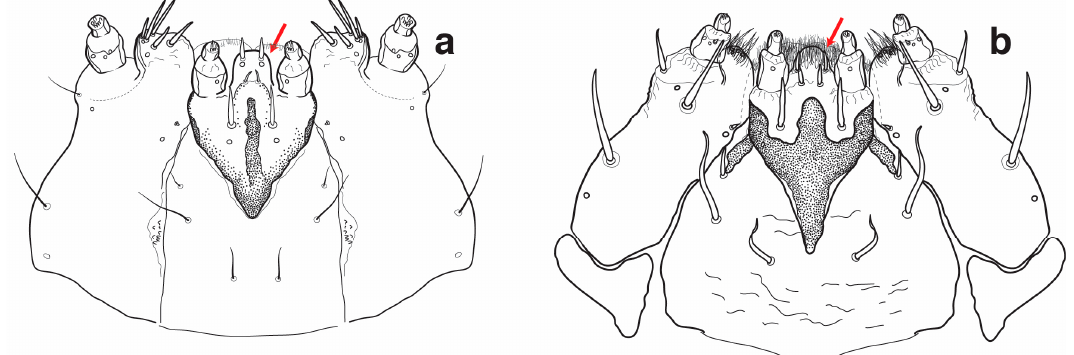
Figure 51. Labium, labio-maxillary complex: ( a ) Rhynchophorus ; and ( b ) Sphenophorus . 2. Ligular seta 1 (lgs1) (Figure 52)